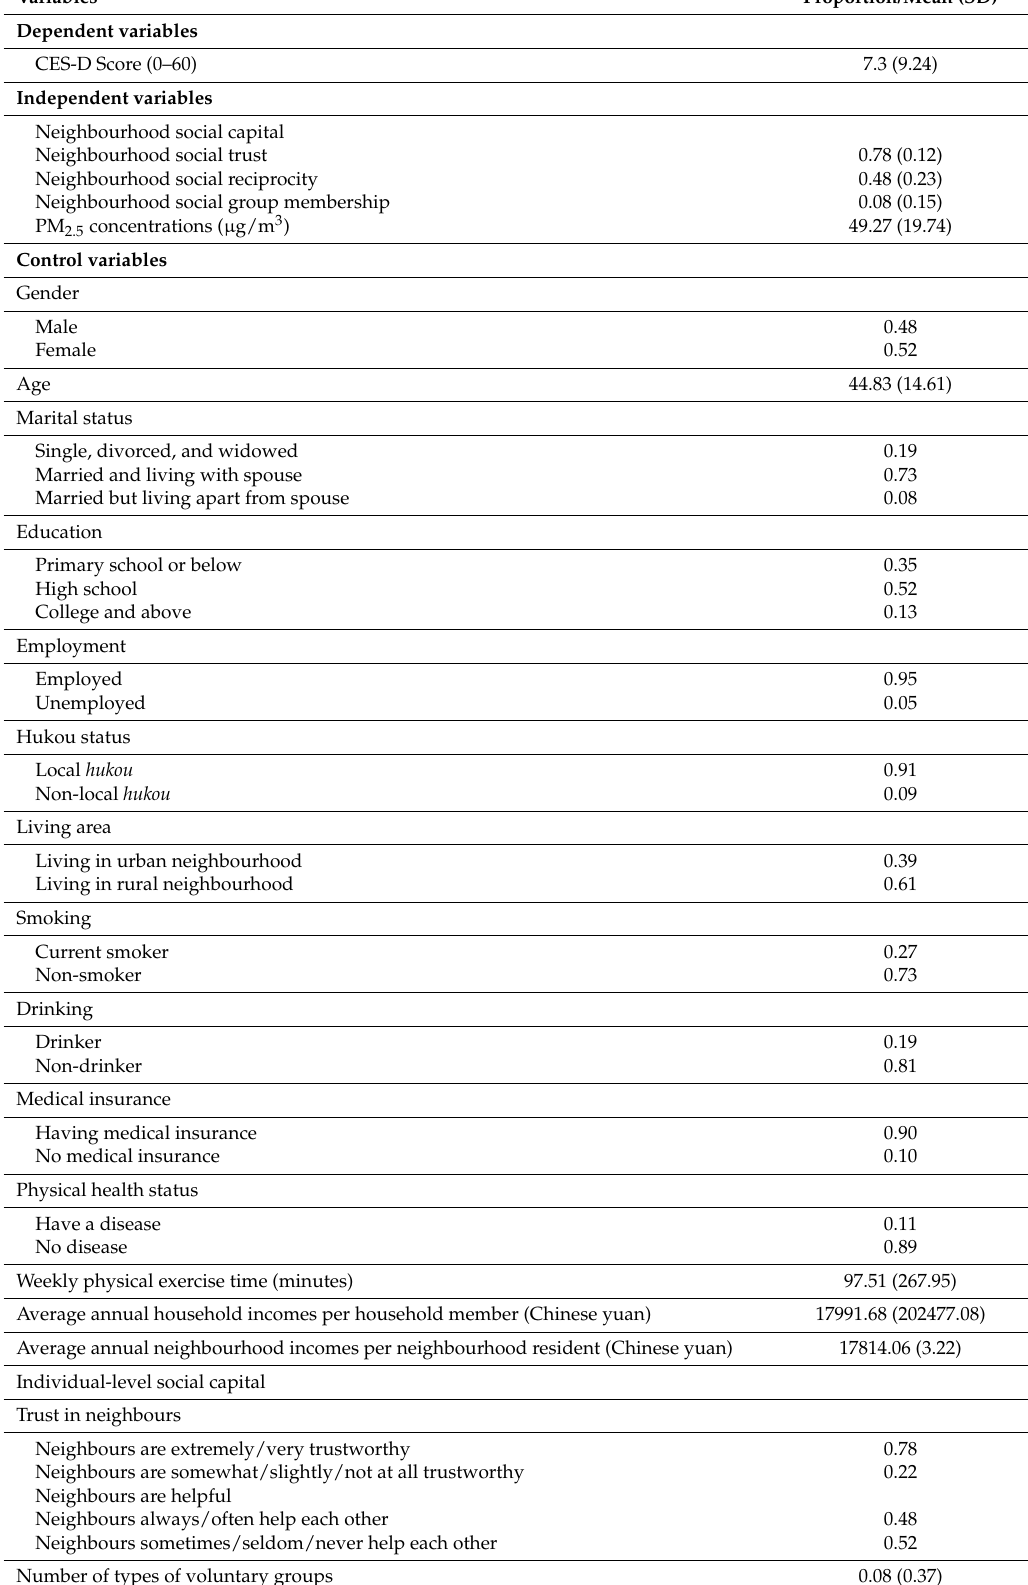
Table 1. Summary statistics of variables included in regression